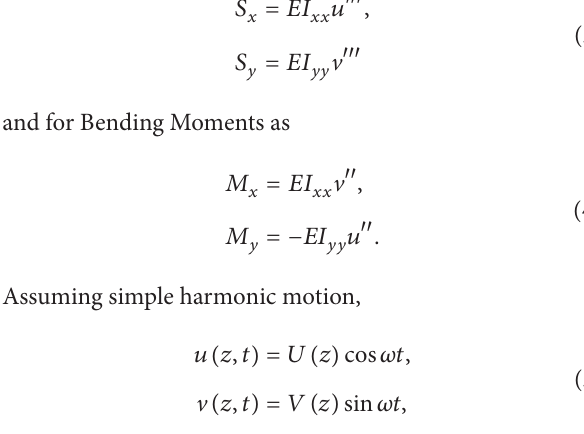
loads are then found to be in the following forms, written for shear forces